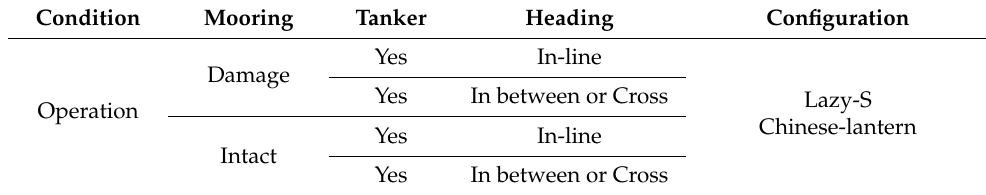
Table 6. Load case for hose analysis.